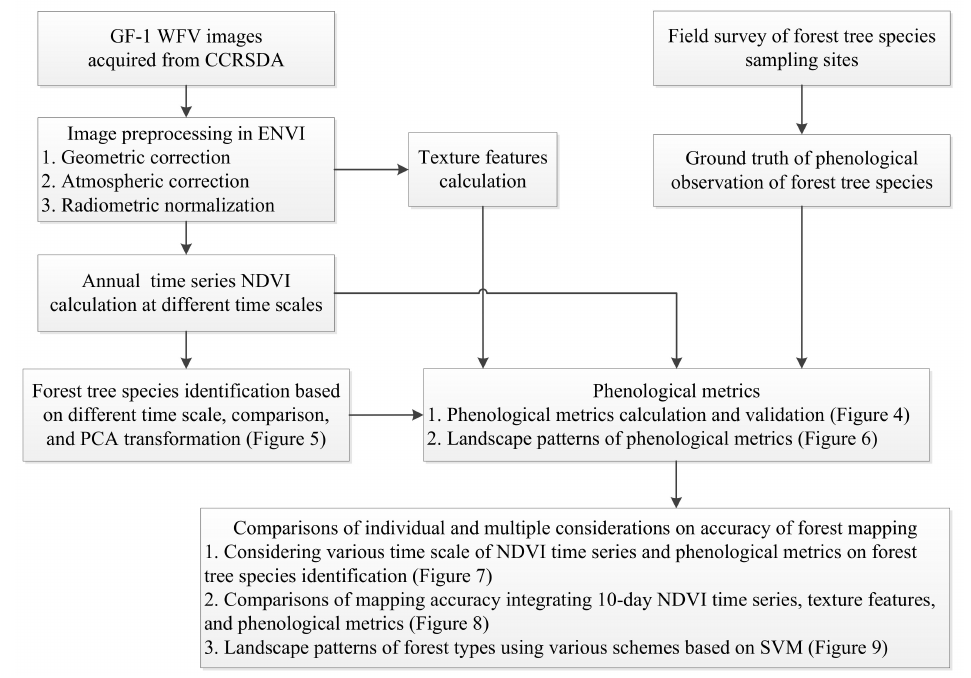
Figure 3. The working flow of major images acquired, data processing, texture feature extractions, phenologiocal metrics calculation, and landscape mapping and accuracy assessment in ENVI and ArcGIS